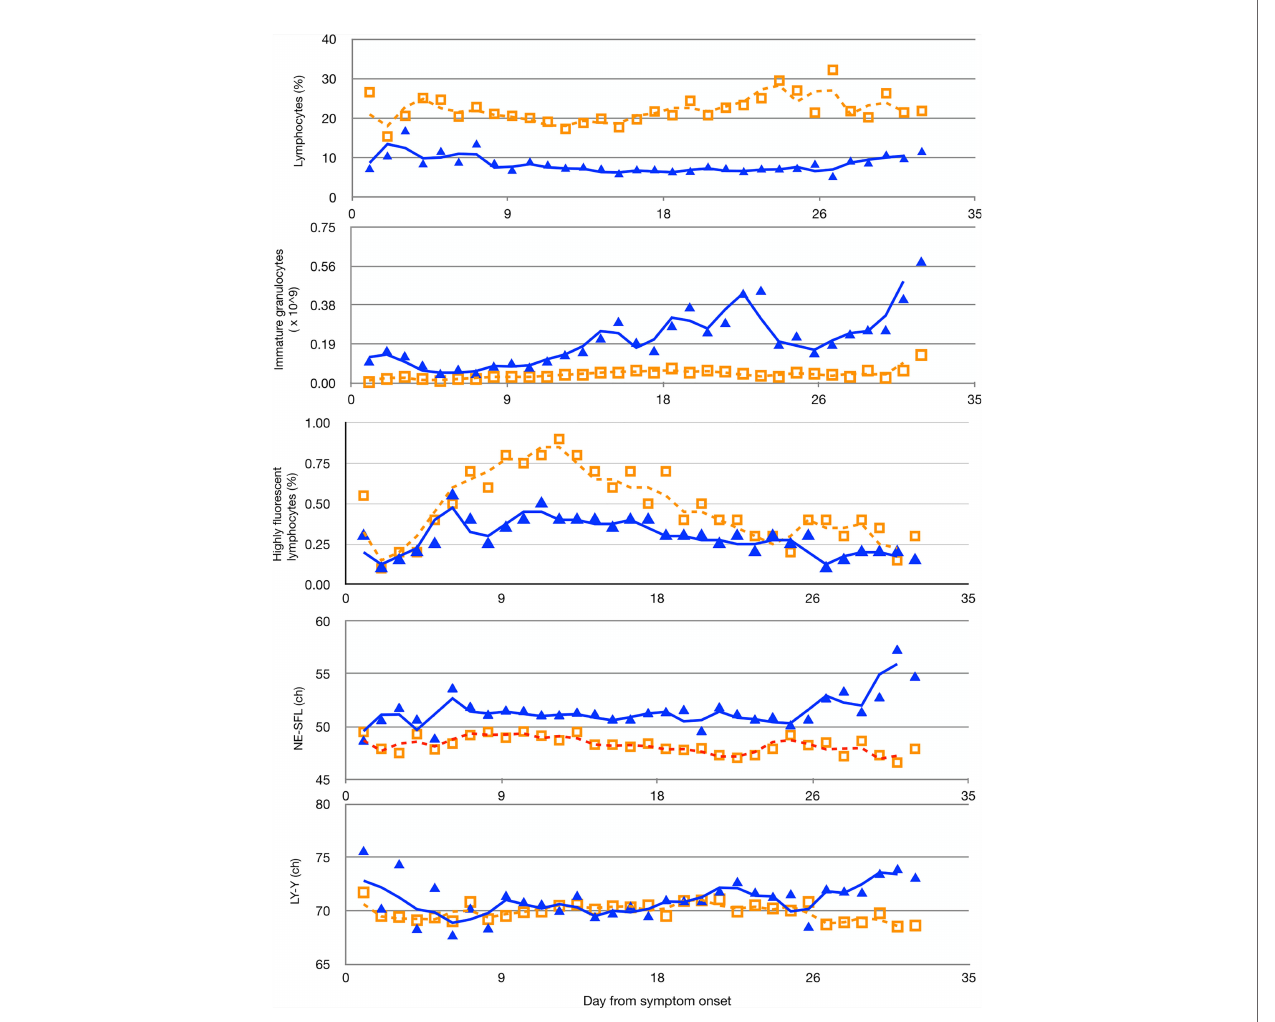
FIGURE 1 | Moving averages of median of multiple measurements of LY%, IG_ABS, HFLC%, the fl uorescent light intensity of the neutrophil area on the leukocyte differential (WDF) scattergram (NE-SFL), and the fl uorescent light intensity of the lymphocyte area on the WDF scattergram (LY-Y), measured in COVID-19 patients according to days from symptom onset. Solid blue triangles and empty orange squares indicate non-survivors and survivors, respectively. ch, channel-arbitrary units of light